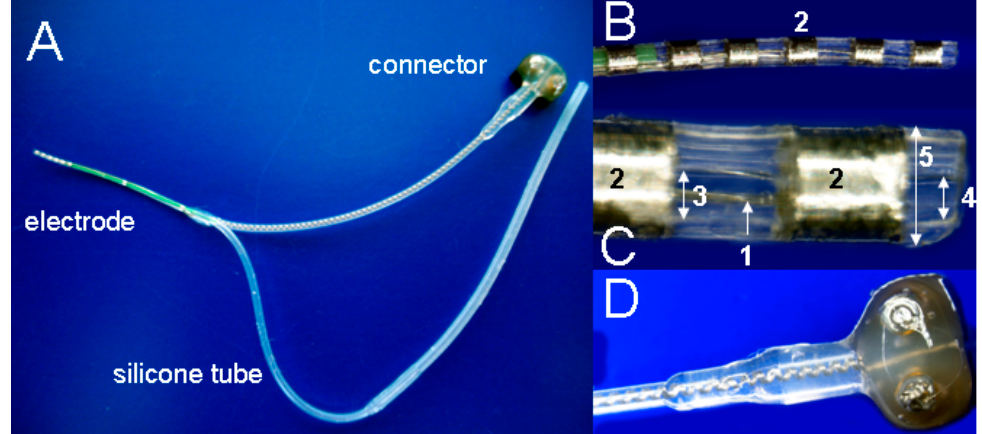
Figure 2. ( A ) The implant consists of an intracochlear electrode array and a silicone tube for local drug delivery. ( B ) Tip of the electrode with 6 contacts (2). ( C ) Further magnification of the electrode tip